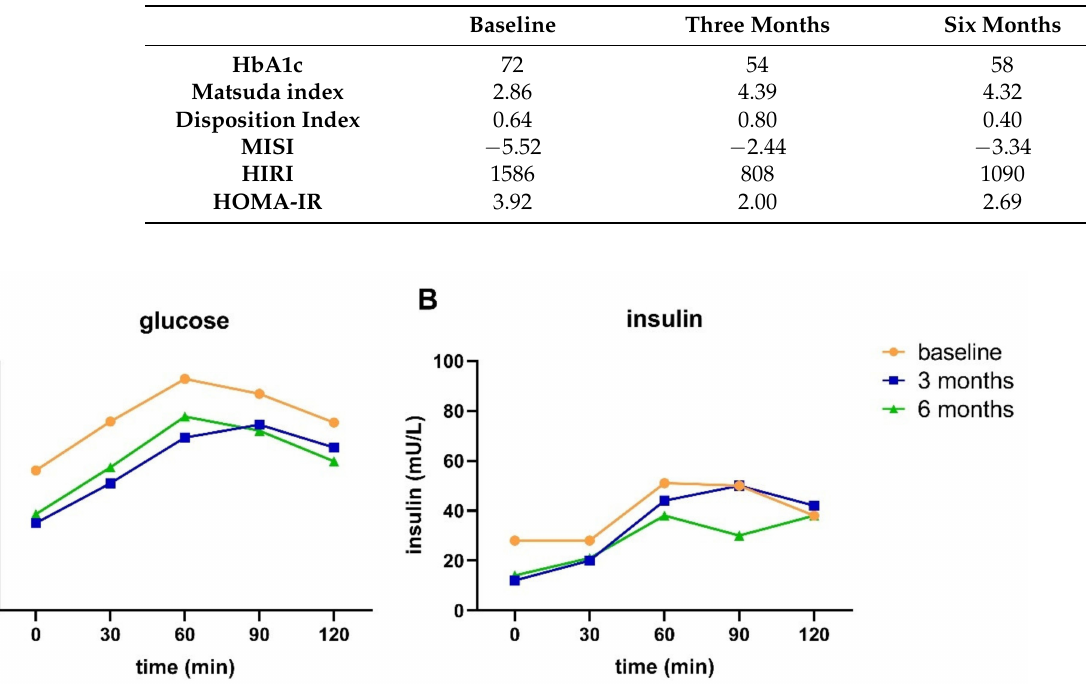
Figure 5. Glucose ( A ) and insulin ( B ) response to an OGTT at baseline and after three and six months of intervention for participant